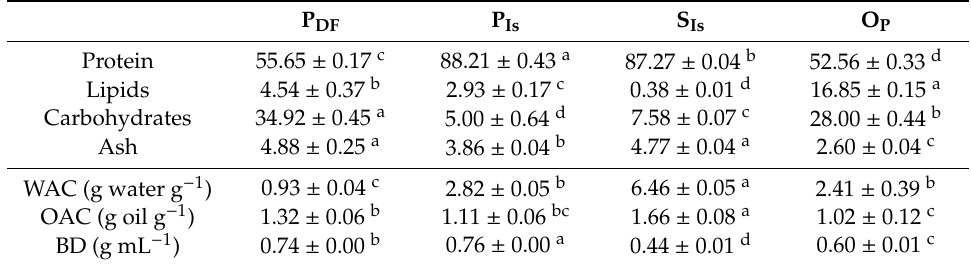
Table 3. Proximate composition (g 100 g − 1 dry matter) and functional properties of the protein powders used as raw materials for the extrusion process. P DF : dry-fractionated pea protein; P Is : pea protein isolates; O P : oat protein; S: soy protein isolates. P DF P Is S Is O P